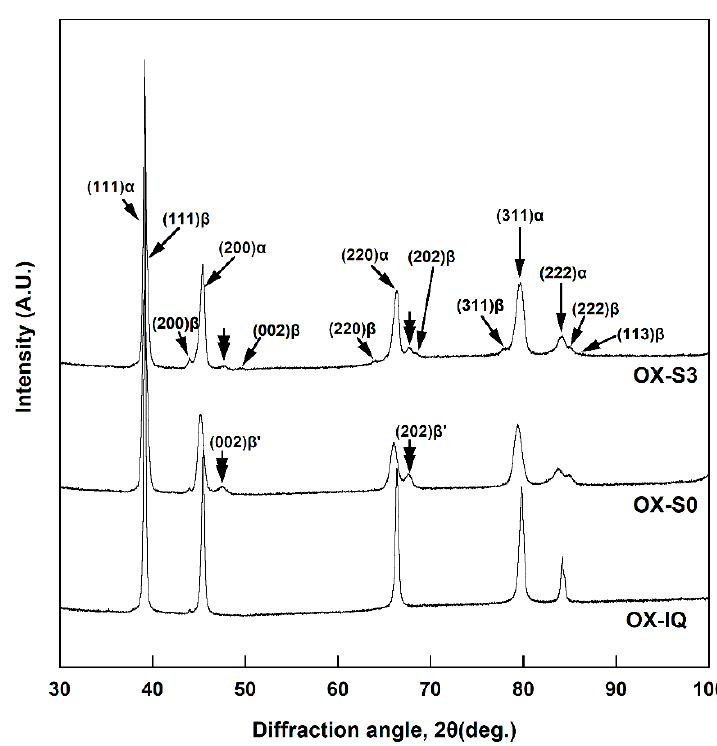
Figure 6. X-ray Diffraction (XRD) patterns of the specimens after oxidation. A.U.: arbitrary unit.